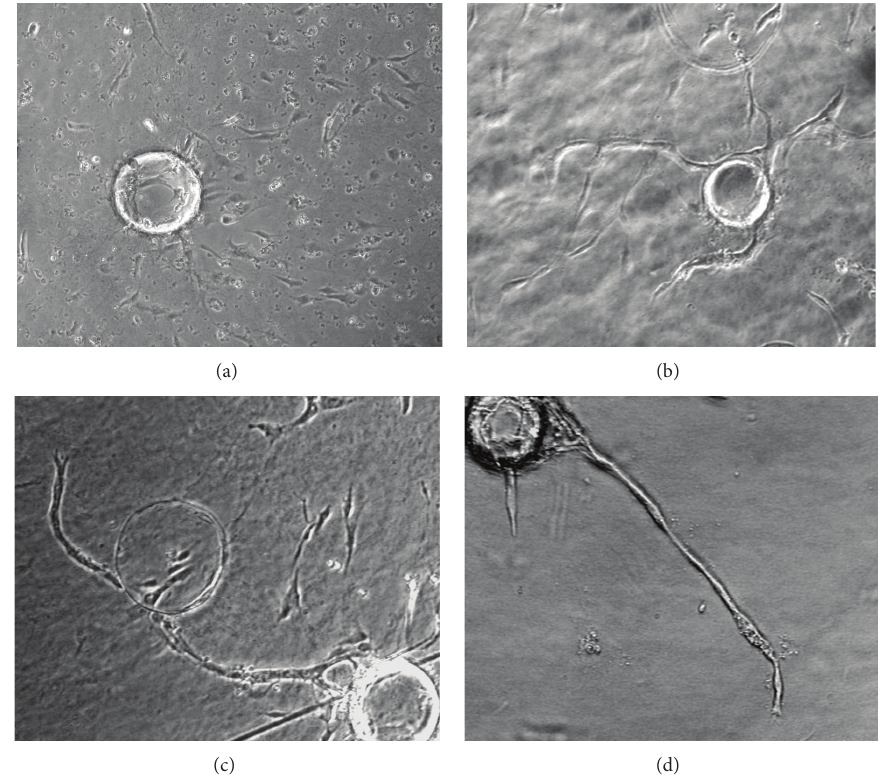
Figure 6: Fibrin facilitated sprout angiogenesis of HDMEC in collagen induced by angiogenic factors combo (30ng/mL VEGF + 25ng/mL bFGF) at 48hr. Angiogenic factors stimulated HDMEC to invade and migrate into pure collagen gel individually without forming capillary sprouts (a). With the addition of 20% fibrin fibrils, by volume (b), or 30% fibrin fibrils, by volume (c), to collagen gel in the presence of angiogenic factors, sprout angiogenesis occurred together with individual cell invasion and migration. Angiogenic factors induced sprout angiogenesis of HDMEC in pure fibrin gel (d) (100x magnification).